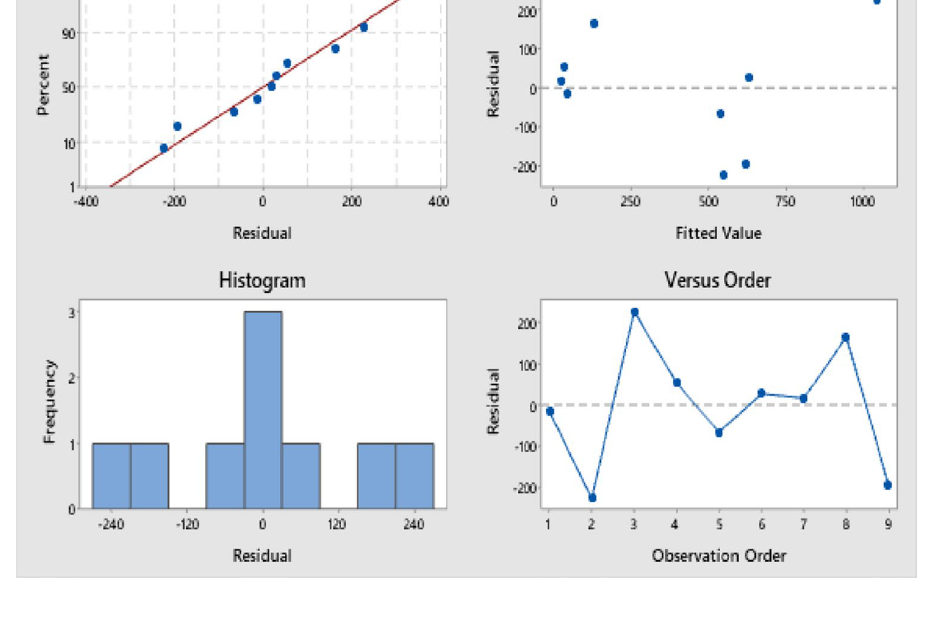
Fig. 23 Residual plot for NOx with